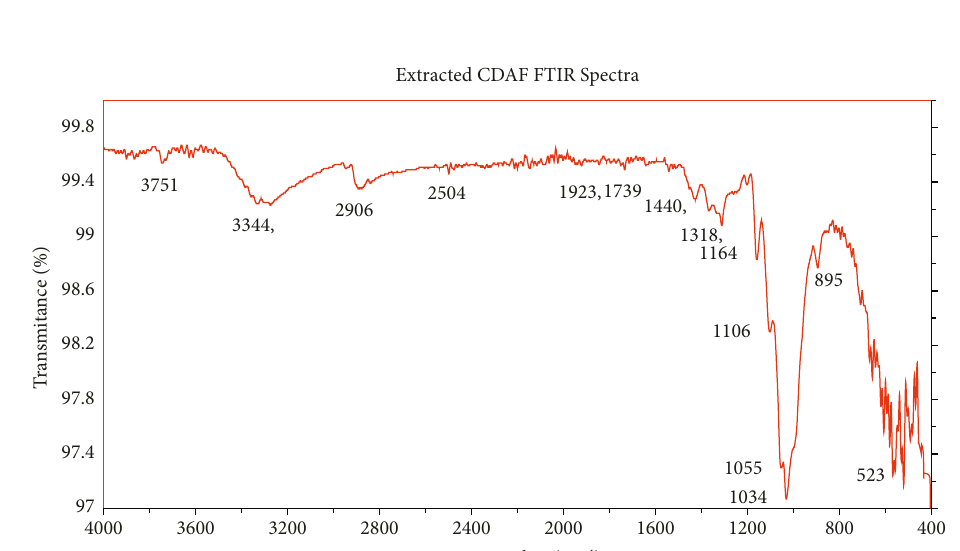
Figure 7: FTIR spectral analysis curve for extracted